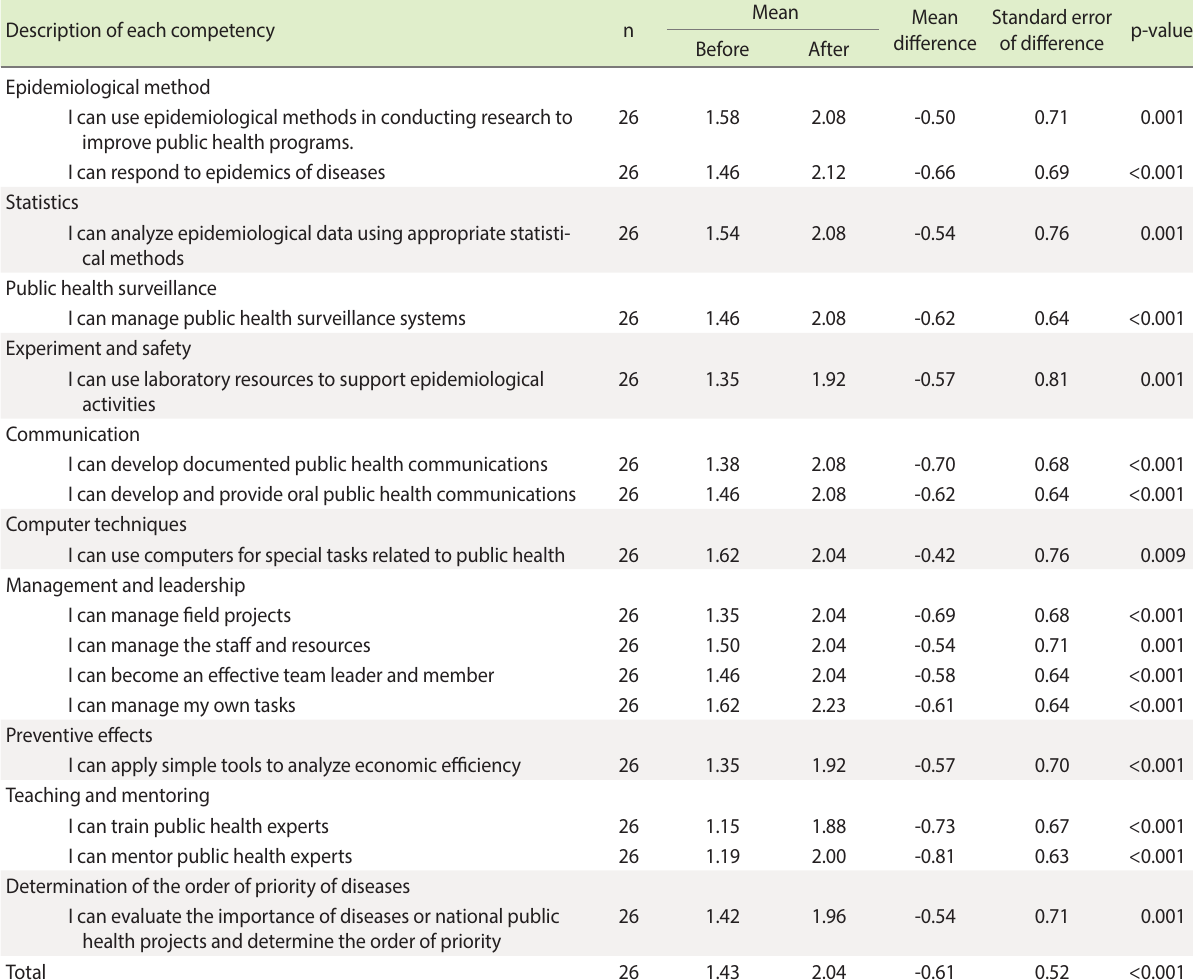
Table 6. Evaluation results of competencies before and after field epidemiology training program in 2016 Description of each competency n